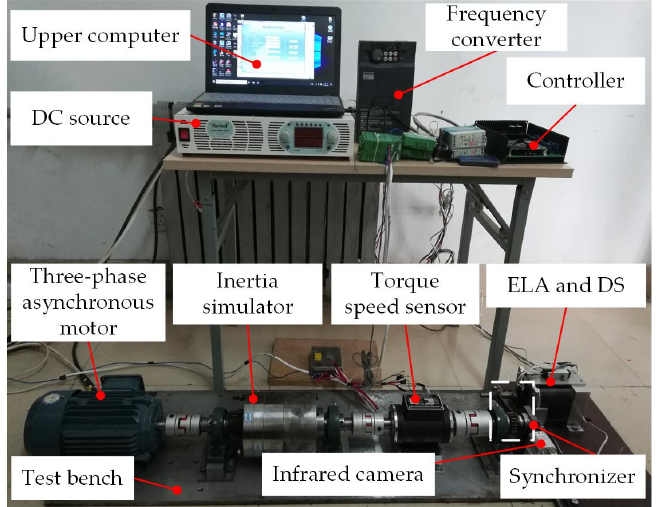
Figure 5. Synchronizer test-control platform.